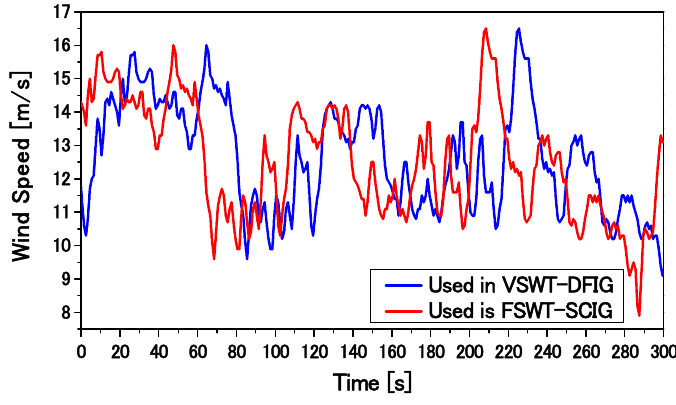
Figure 32. Wind speed data.